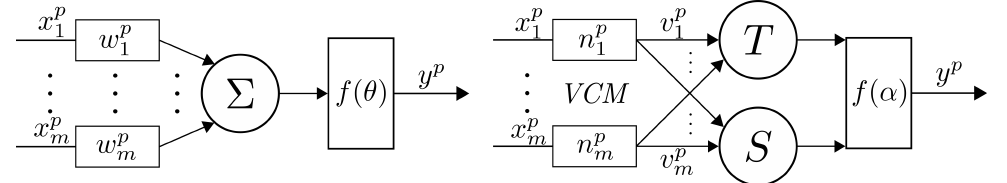
Figure 1. Architectures of the proposed L-neuron ( right ) and Pitts–McCulloch models ( left ) feature a similar dataflow pipeline: input transformation (weighting vs. VCM), aggregation (scalar vs. vector- ized, through T - and S -norms) and scalar output generation (nonlinear function vs. linear